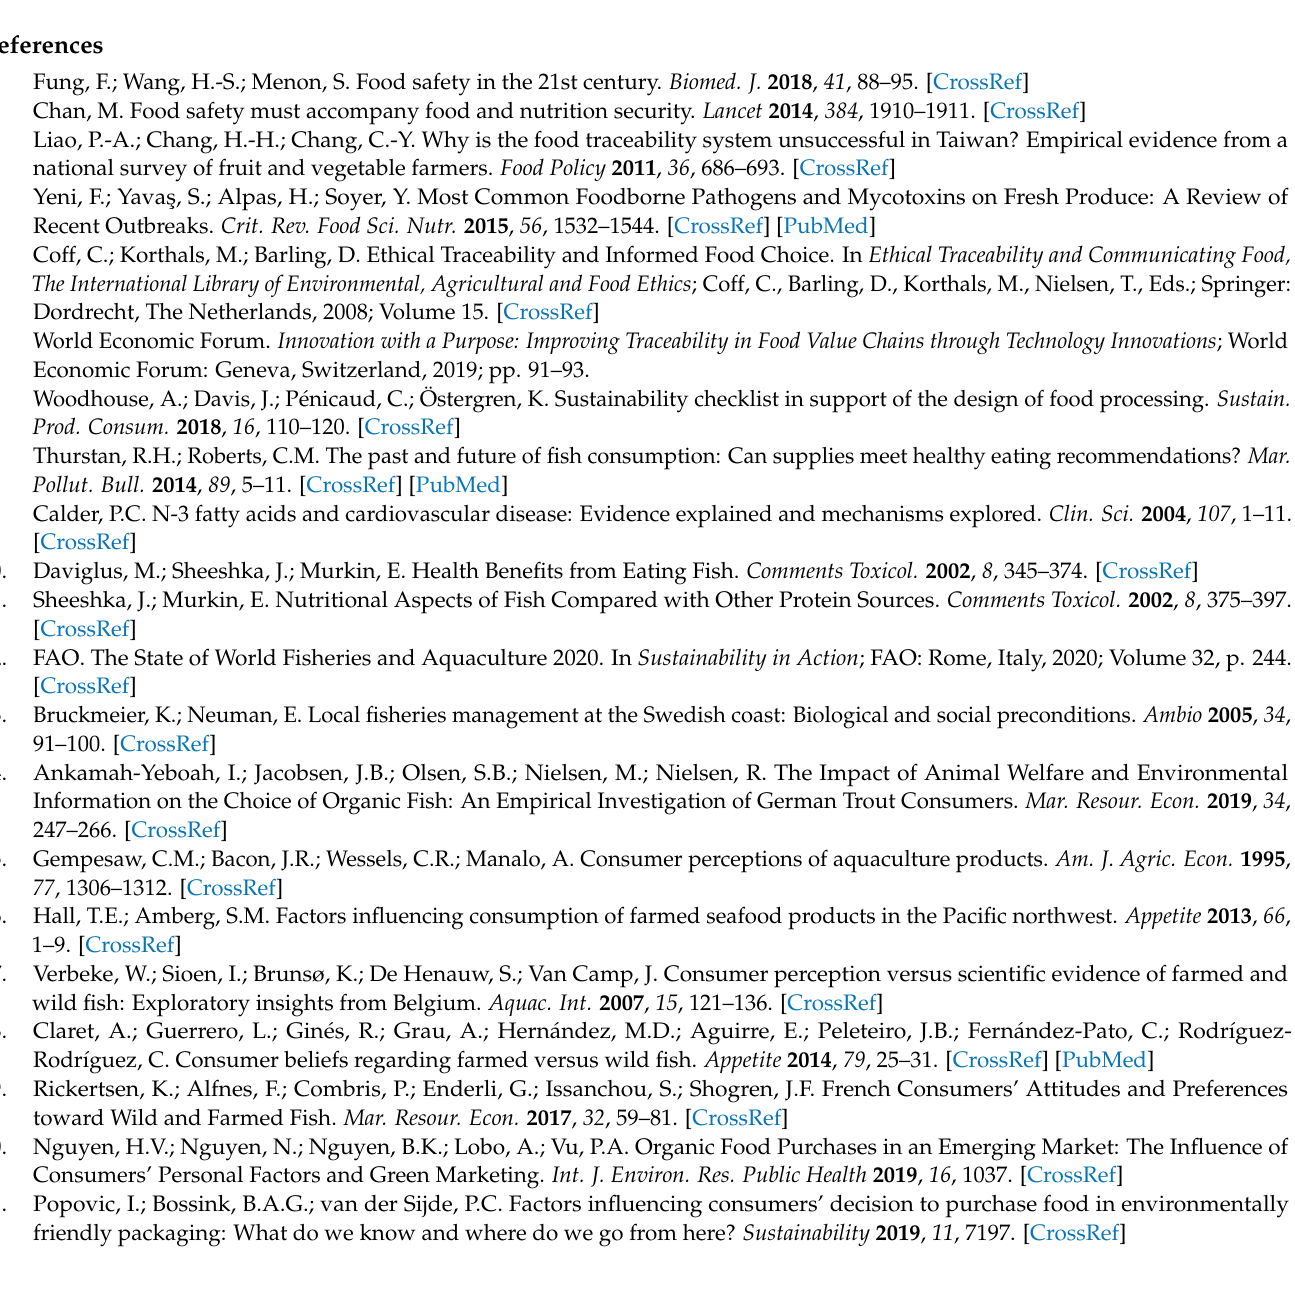
Table A1. Cont. No authority ensures or claims that fishes during No safety claim storage, processing & distribution are free from formalin. Fish that are under control in the production process. Pesticide residues, theJ123Marijamicroorganism content, preservative, and heavy metals within the Safe farmed fish food comply with authority or government standards and are safe for consumers but not sustainable [91]. The raising and breeding of fish, in this case, finfish, applying many pesticides and traditional fishmeal to Conventional farmed fish increase the growth of the fish rapidly, ignoring food safety